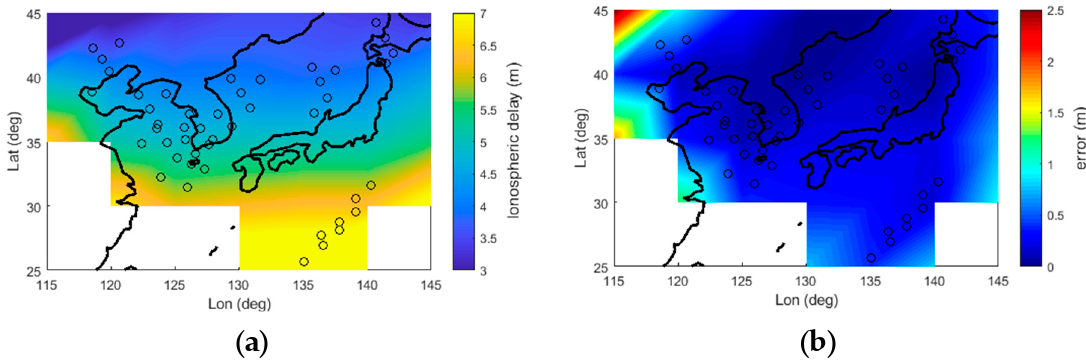
Figure 1. ( a ) Estimated ionospheric map and ( b ) its error in the case using only the double-difference carrier phase.